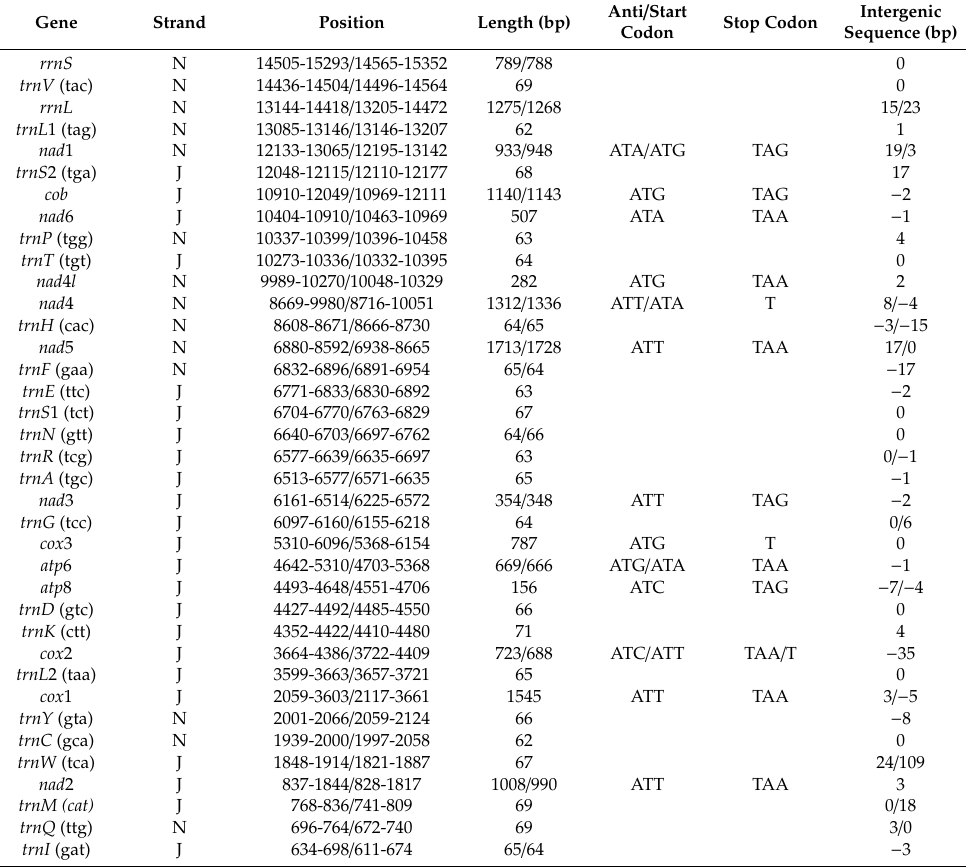
Note: N and J indicates that the gene was located in the minor (N) and major (J) strand. The ‘ / ‘ indicates that the left was C. dimidiatus and the right was C. pilosellus . Intergenic sequence: positive numbers/negative numbers indicate intergenic/overlapping regions between adjacent genes.